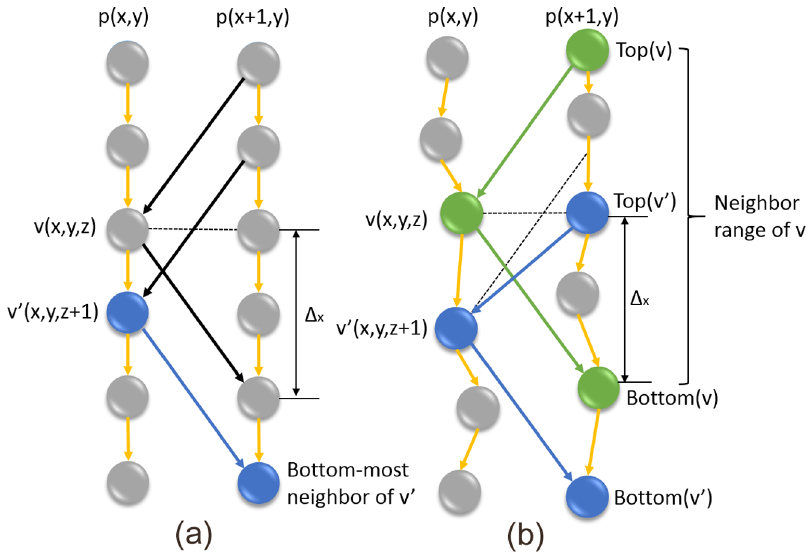
Figure 5. Structure of conventional graph (a) and non-Euclidean deformed graph (b). In (a), node u ’ and its bottom-most neighbor are shown in dark blue. In (b), node u , Top ( u ) , Bottom ( u ) are shown in green and node u ’ , Top ( u ’ ) , Bottom ( u ’ ) are shown in dark blue.